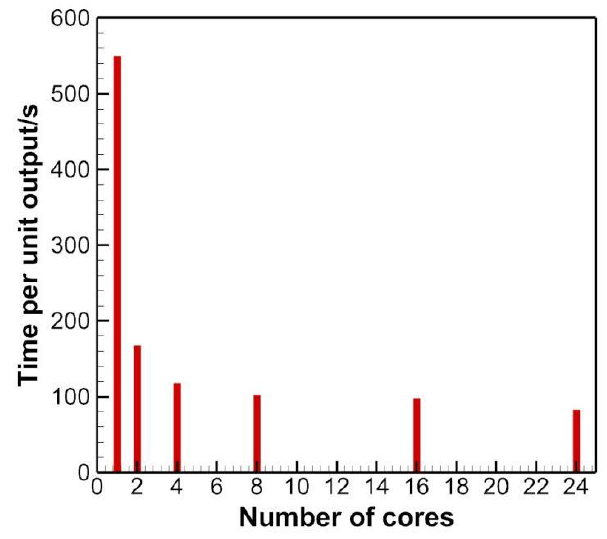
Figure 7. Efficiency of the parallel algorithm.